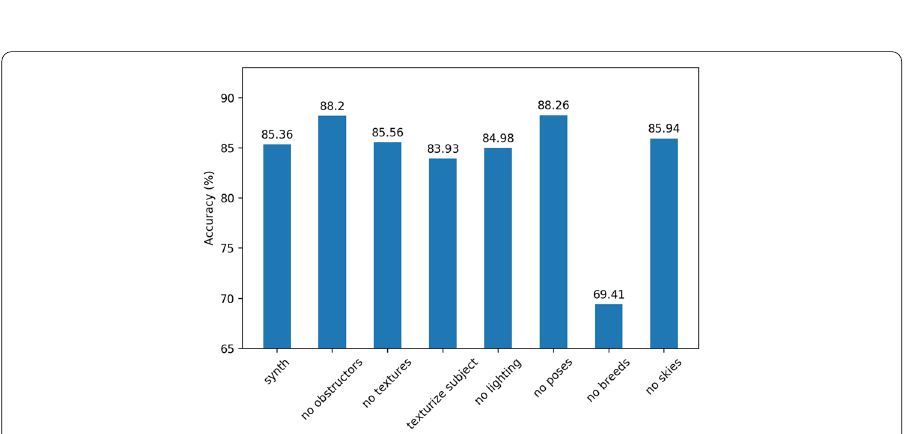
Fig. 4 Optimal accuracy of models trained using different synthetic datasets. “Synth” represents the control model trained on domain randomization techniques outlined in Sect. "Methods/experimental" using dropout. The others represent datasets were a certain parameter was omitted in the data generation processes such as lighting or textures. We also go a step further and texturize the cats and dogs in what is labelled as “texture subject”